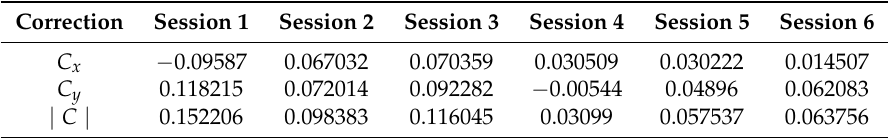
Figure 14. Boxplots of deviations in X ( left ) and Y ( right ) per experiment session. Table 1. Vector components and lengths used for bias correction of measured target positions from different experiment sessions. Values are stated in